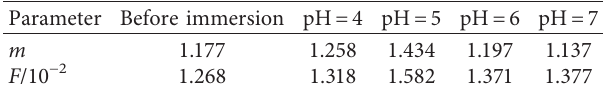
Figure 17: Fitting curve of E at different pH Table 6: Values of m and F in different states.